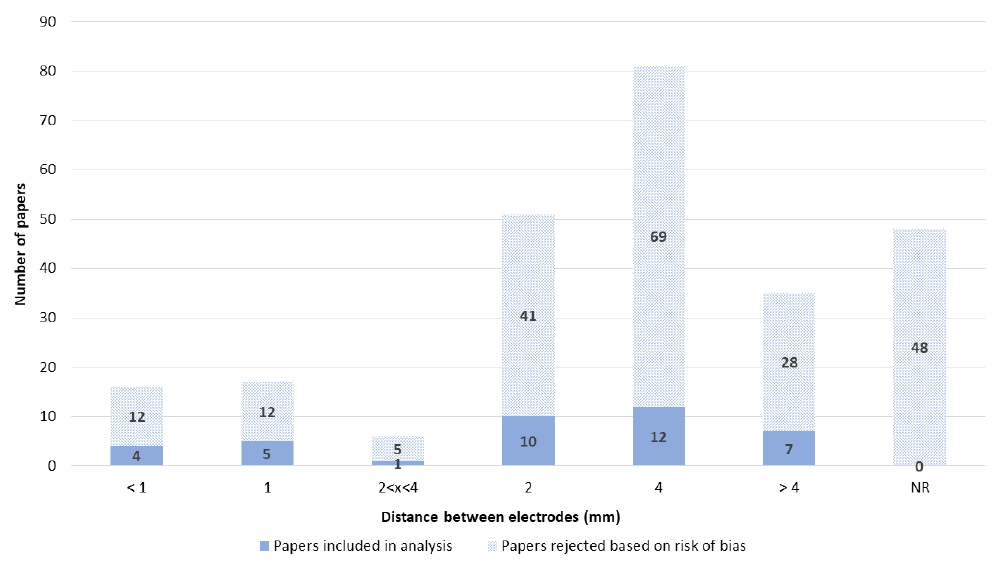
Figure 5. Distance between the electrodes. NR—not reported.